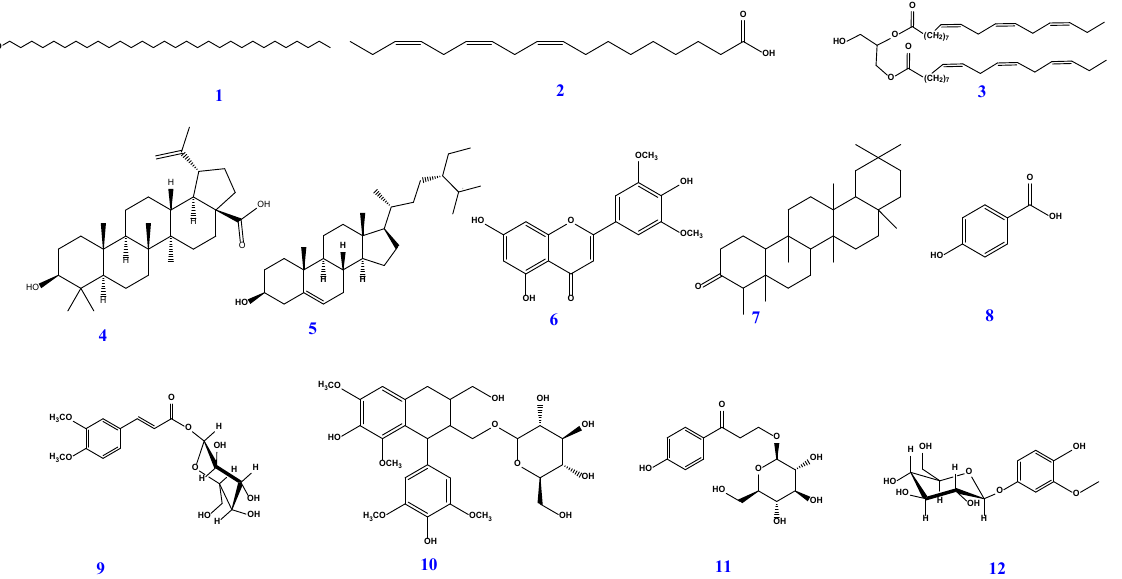
Figure 5. Chemical structures of compounds 1–12, isolated from peels of P. pubescens . 2.4. Effects of Bamboo Isolated Compounds on Production of Melanin, Hyaluronic Acid, and Collagen To estimate the function of isolated compounds from P. pubescens peel against human skin, we examined the effect of isolated compounds from P. pubescens peel on production of melanin, hyaluronic acid, and collagen. to B16 melanoma cell. Betulinic acid, tachioside, and 1,2-dilinolenin significantly suppressed melanin production per cell compared to control.